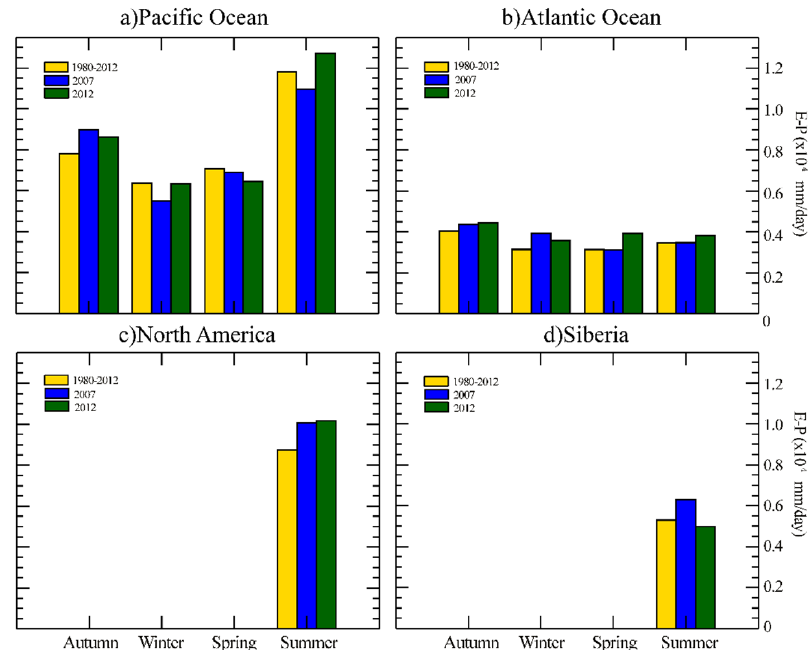
Figure 8. Seasonal mean moisture contribution over the total Arctic domain for 1980–2012 (yellow bar), 2006/2007 (blue bar) and 2011/2012 (green bar) from ( a ) Pacific Ocean; ( b ) Atlantic Ocean; ( c ) North America and ( d ) Siberia.